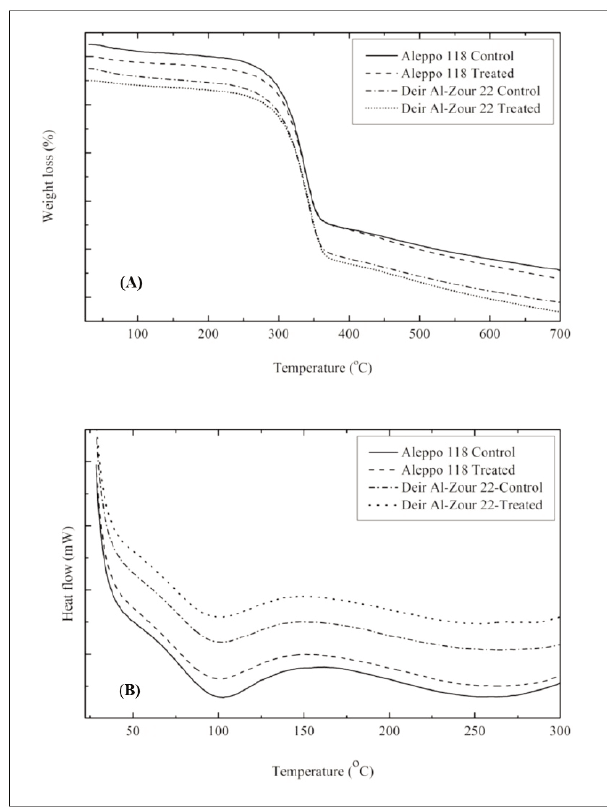
Fig. 6 - (A) TGA thermograms of cotton fibers in presence of nitrogen. (B) DSC thermograms of cotton fibers in pre- sence of nitrogen.